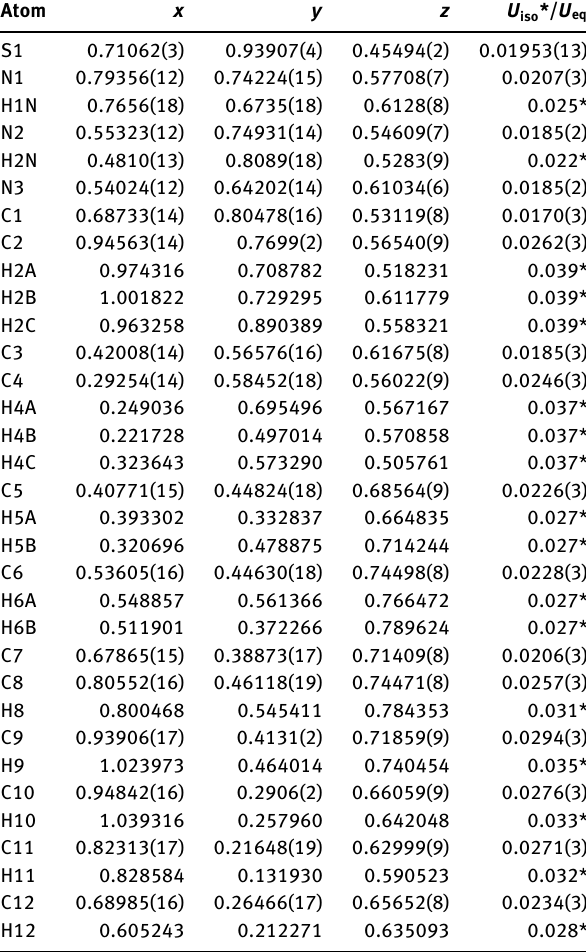
Table 2: Fractional atomic coordinates and isotropic or equivalent isotropic displacement parameters (Å 2